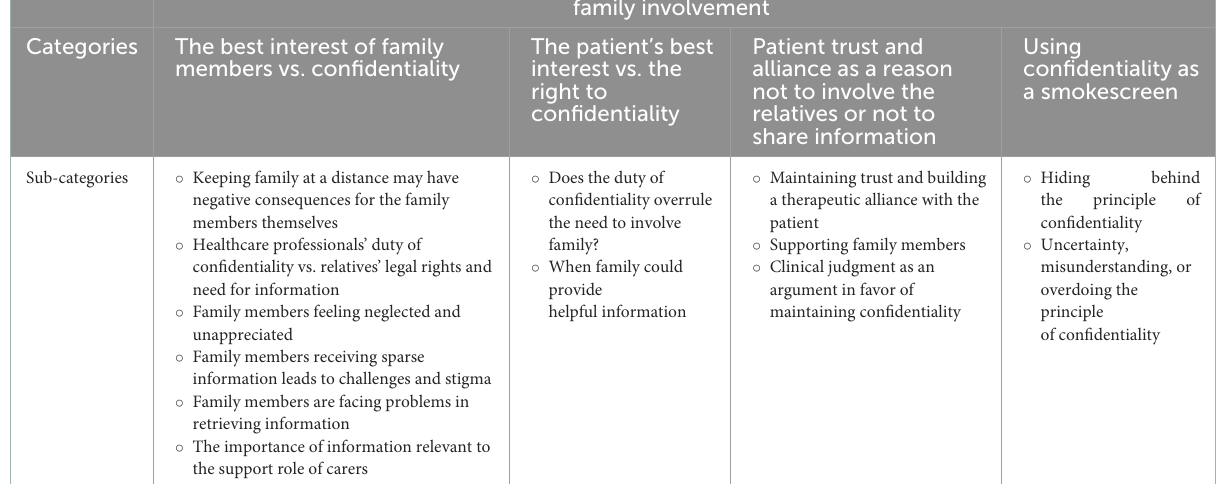
TABLE 1 Overview of the theme, categories and subcategories from the